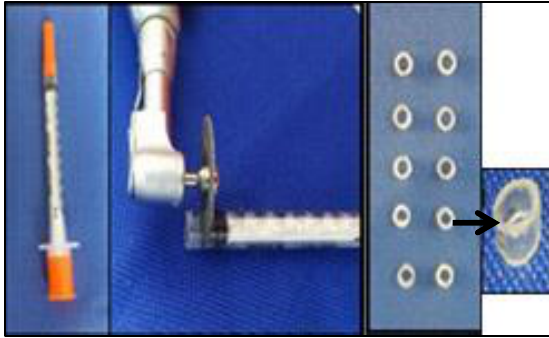
Figure 2: A. Insulin empty syringe 1Ml; B. Slicing by hand piece; C. The mold obtained.